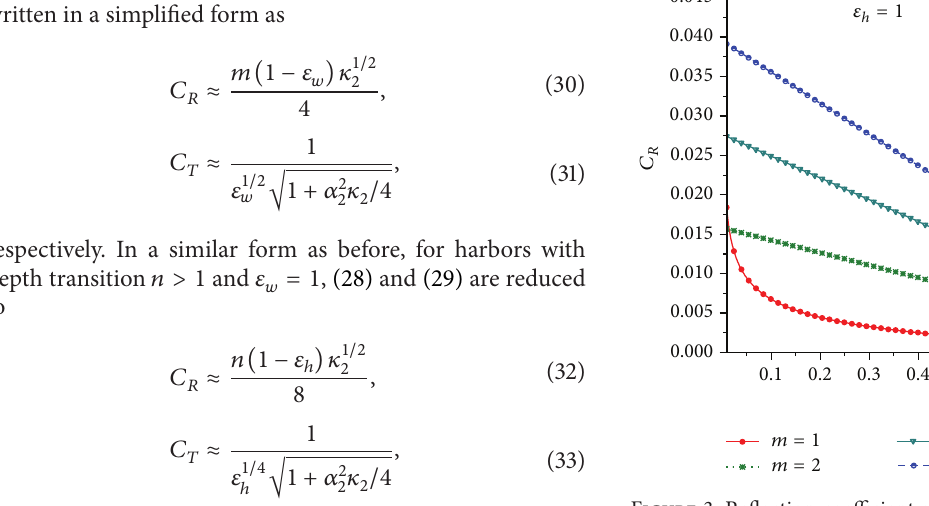
Figure 3: Reflection coefficient as a function of the dimensionless parameter 𝜀 𝑤 , for waves propagating in a harbor with width transitions 𝑚(= 1 , 2 , 3 . 5 , 5 ) , with 𝜀 ℎ = 1 and 𝜅 2 = 0 . 001.